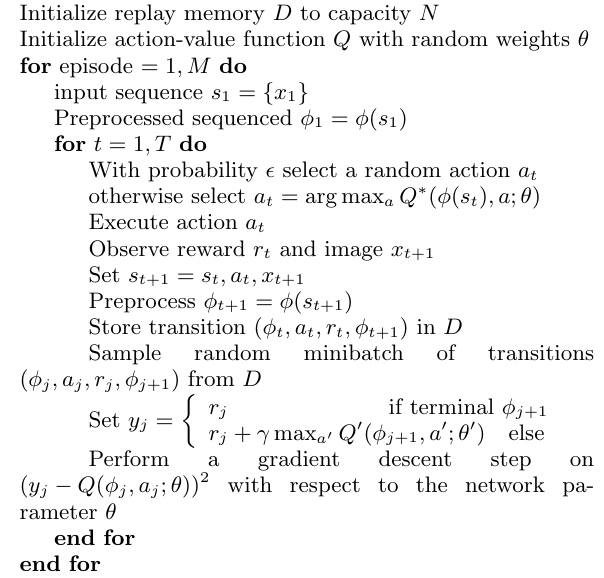
Algorithm 1 Deep Q-learning with Experience Replay [6]